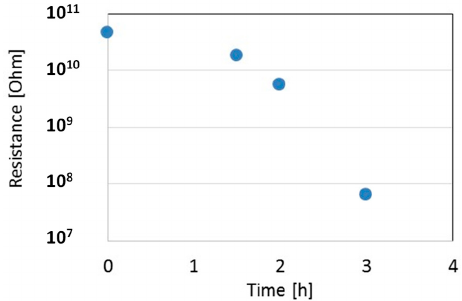
Figure 7. Resistance of the thin film as measured during deposition at 200 ◦ C. Film growth rate is about 0.01